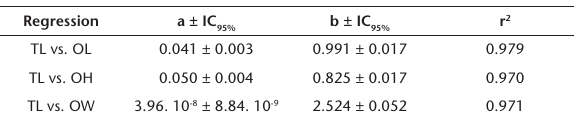
Table 1. Trachurus lathami: coefficients of potential regressions be- tween total length (TL, mm) and otolith length (OL, mm), height (OH, mm) and weight (OW, g). (r 2 ) Coefficient of determination, n =